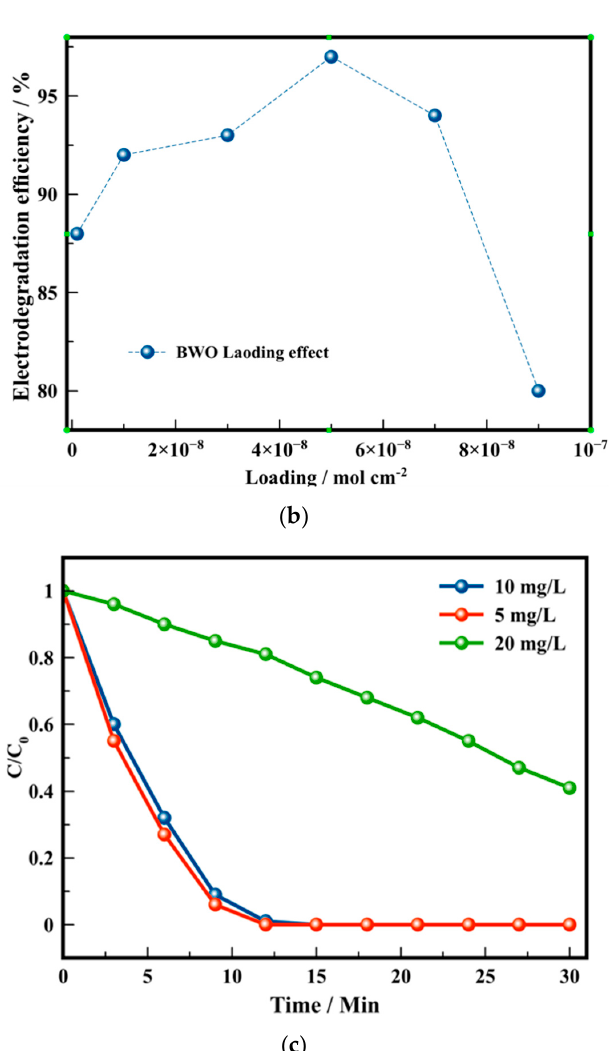
Figure 7. ( a ) The effect of current density on RhB dye degradation efficiency; ( b ) the effect of BWO loading on RhB electrodegradation; and ( c ) the effect of electrolyte concentration on RhB oxidation.